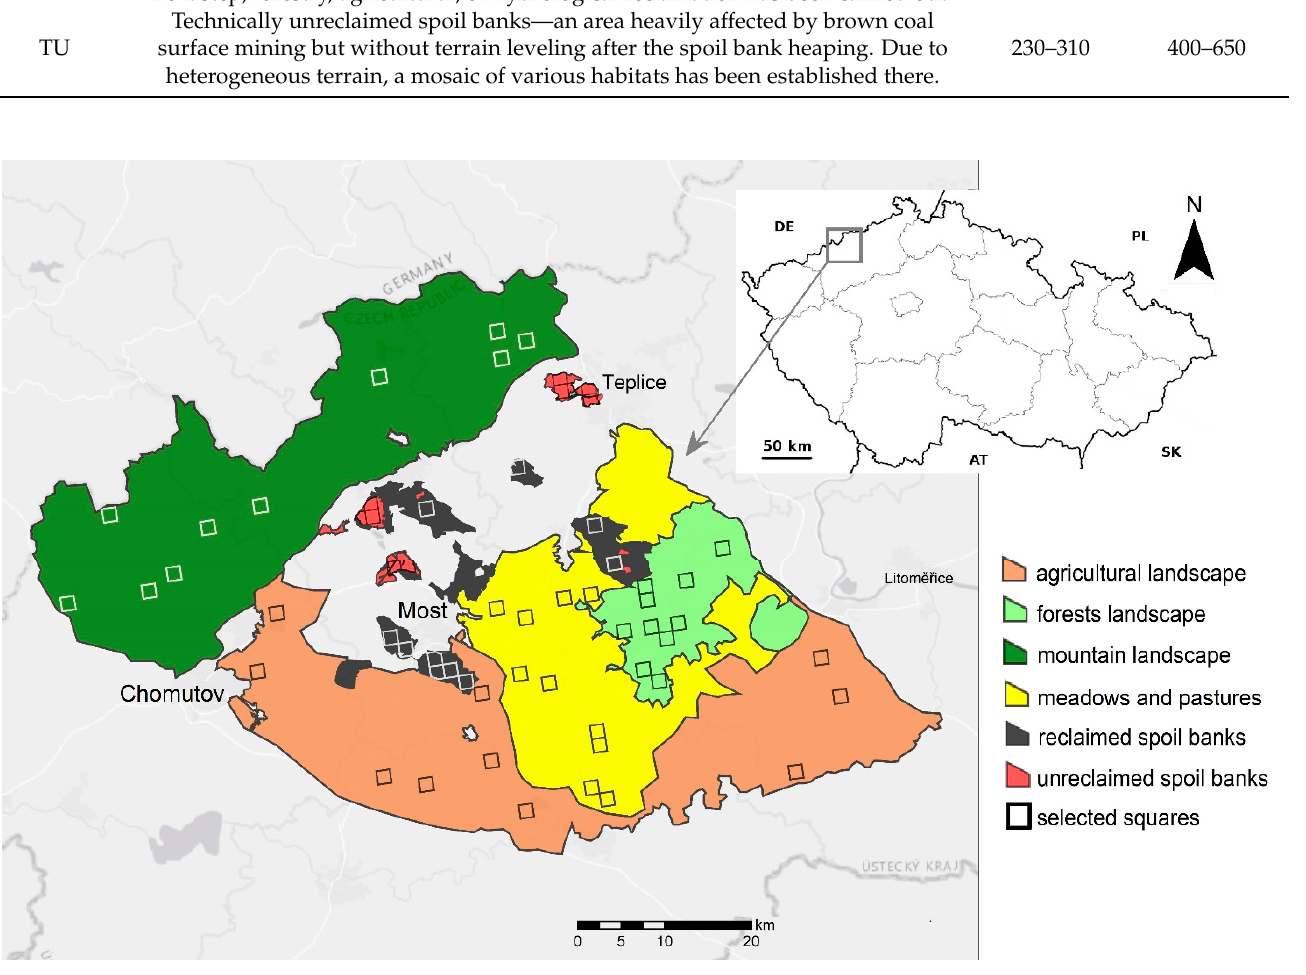
Figure 1. Study area—delimitation of the assessed landscape types. Table 1. Description of selected landscape types in the study area. Abbreviations of landscape types are explained within their descriptions.